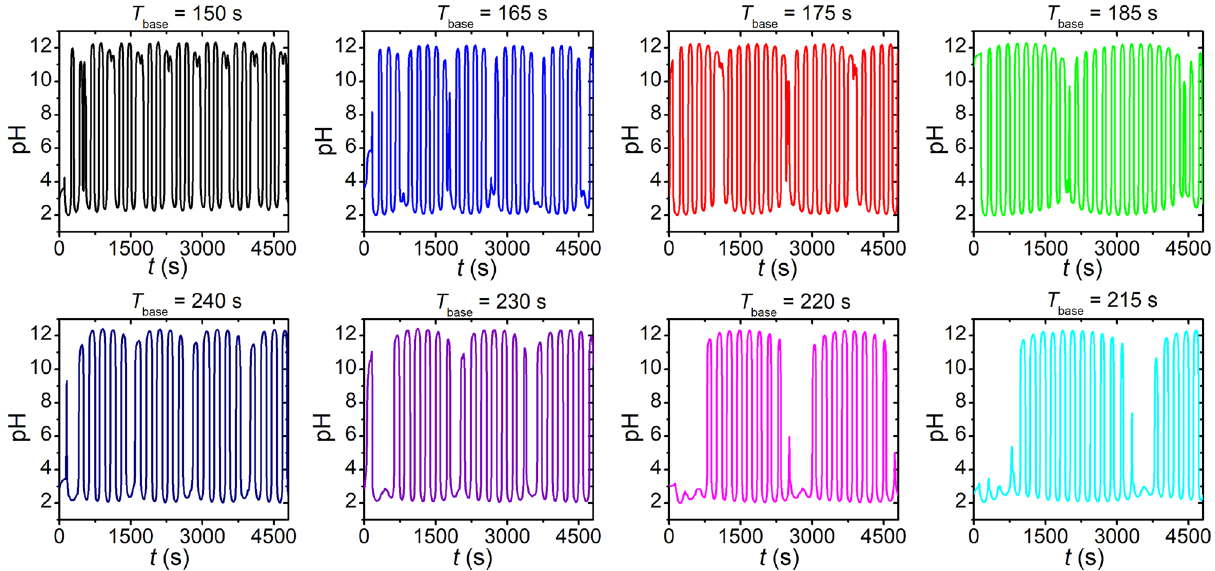
2 π 2 π r ( t ) = r 0 + r A sin r ( t ) = r 0 + r A sin t t + ϕ and alkaline T acid T base (cid:31) (cid:31) (cid:31) (cid:31) (cid:30)(cid:30) (cid:30)(cid:30)